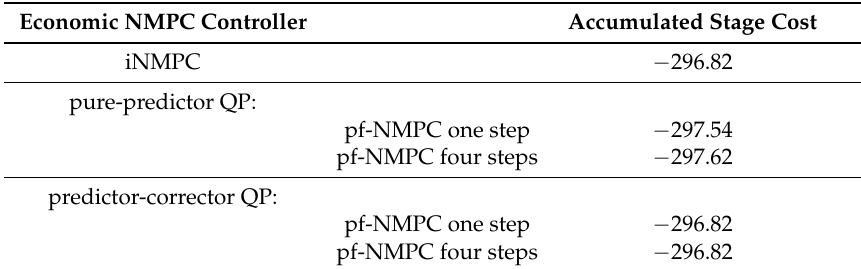
Table 5. Comparison of economic NMPC controllers (with noise). Accumulated stage cost in